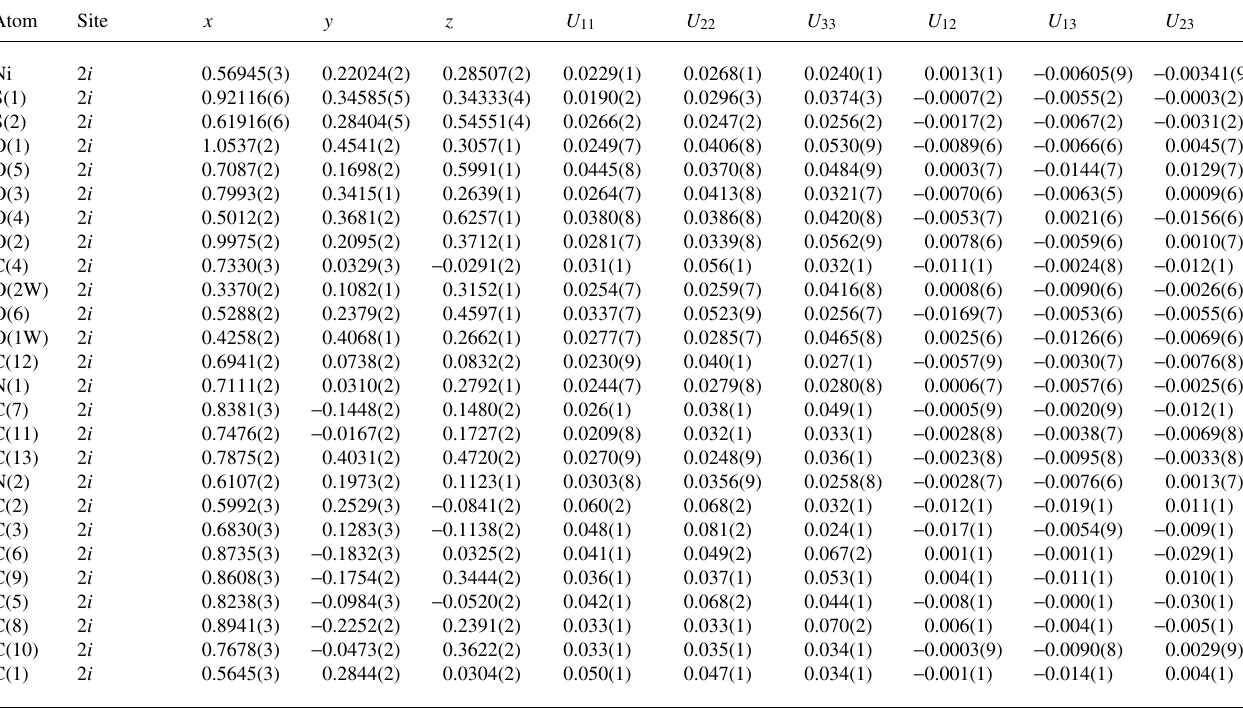
Table 3. Atomic coordinates and displacement parameters (in Å 2 )